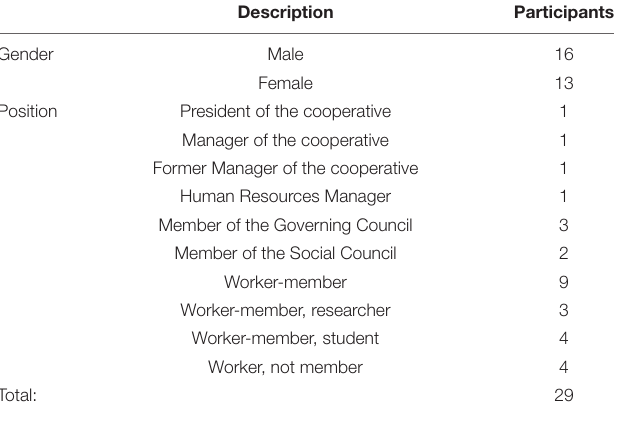
TABLE 2 | Characteristics of